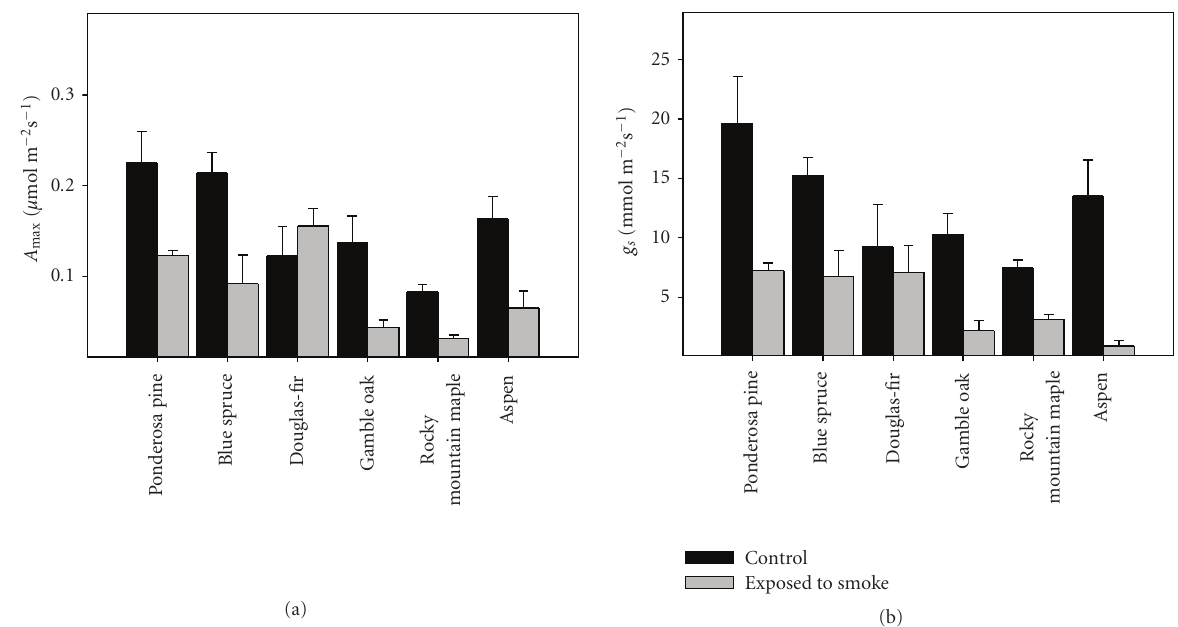
Figure 1: A max (maximum rate of photosynthesis) and g s (stomatal conductance) after 30 minutes of smoke exposure. The only species without significant di ff erences between treatments (at α < 0 . 05 level) was Douglas-fir.